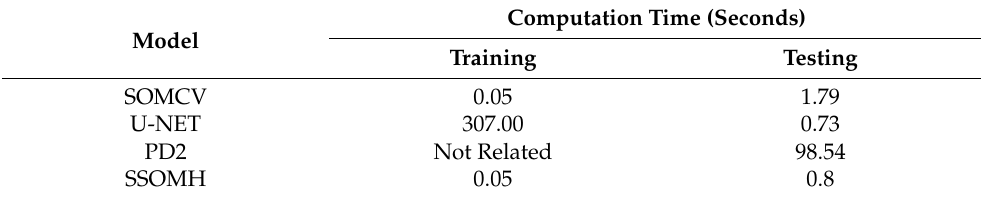
Table 4. Average Computation Time for All Models.